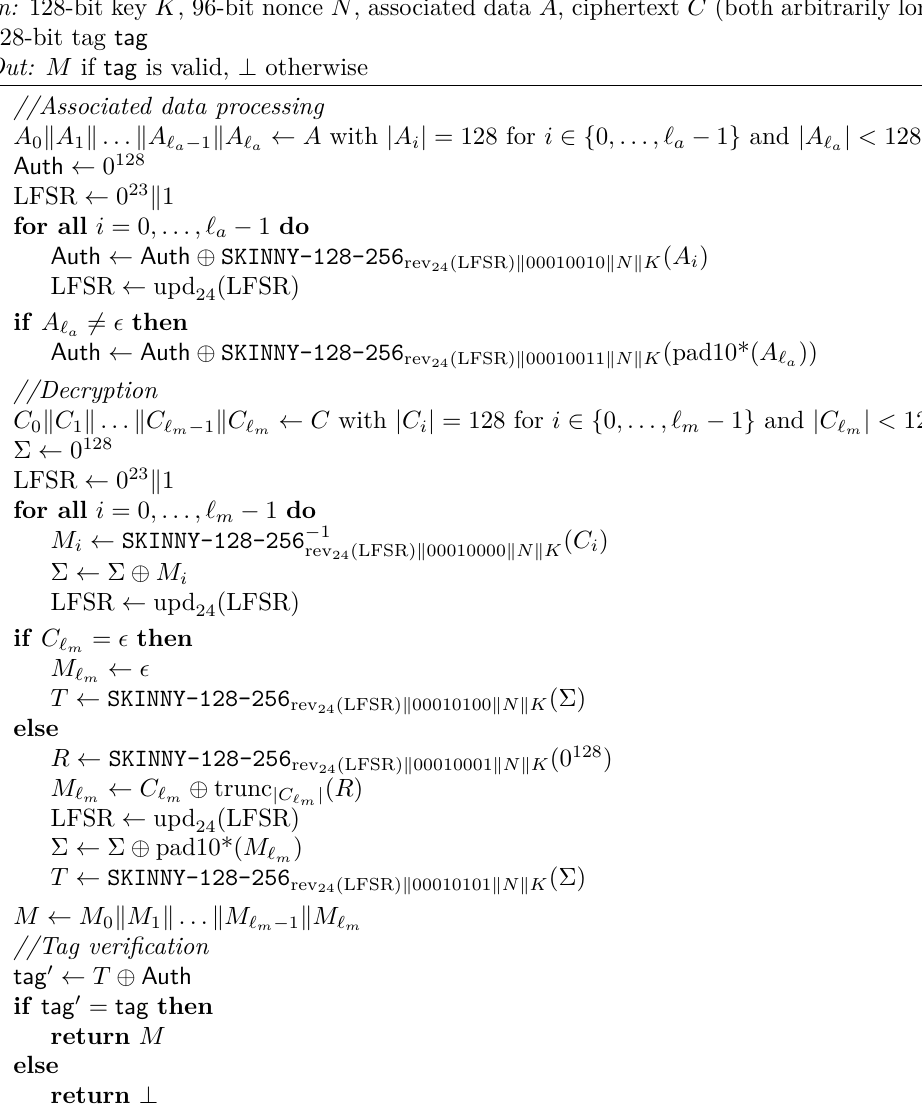
Algorithm 12 The decryption algorithm SKINNY - AEAD - M5 - Dec ( K, N, A, C, tag